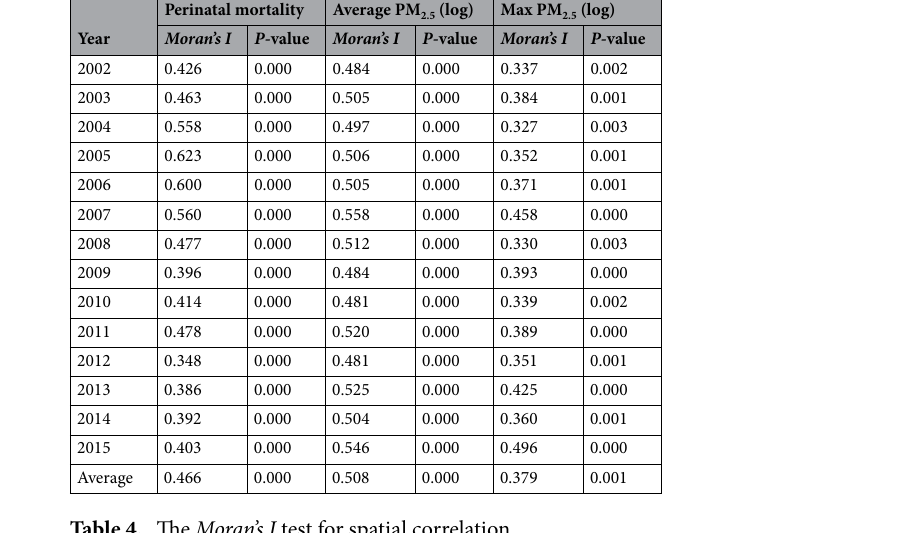
Table 4. The Moran’s I test for spatial